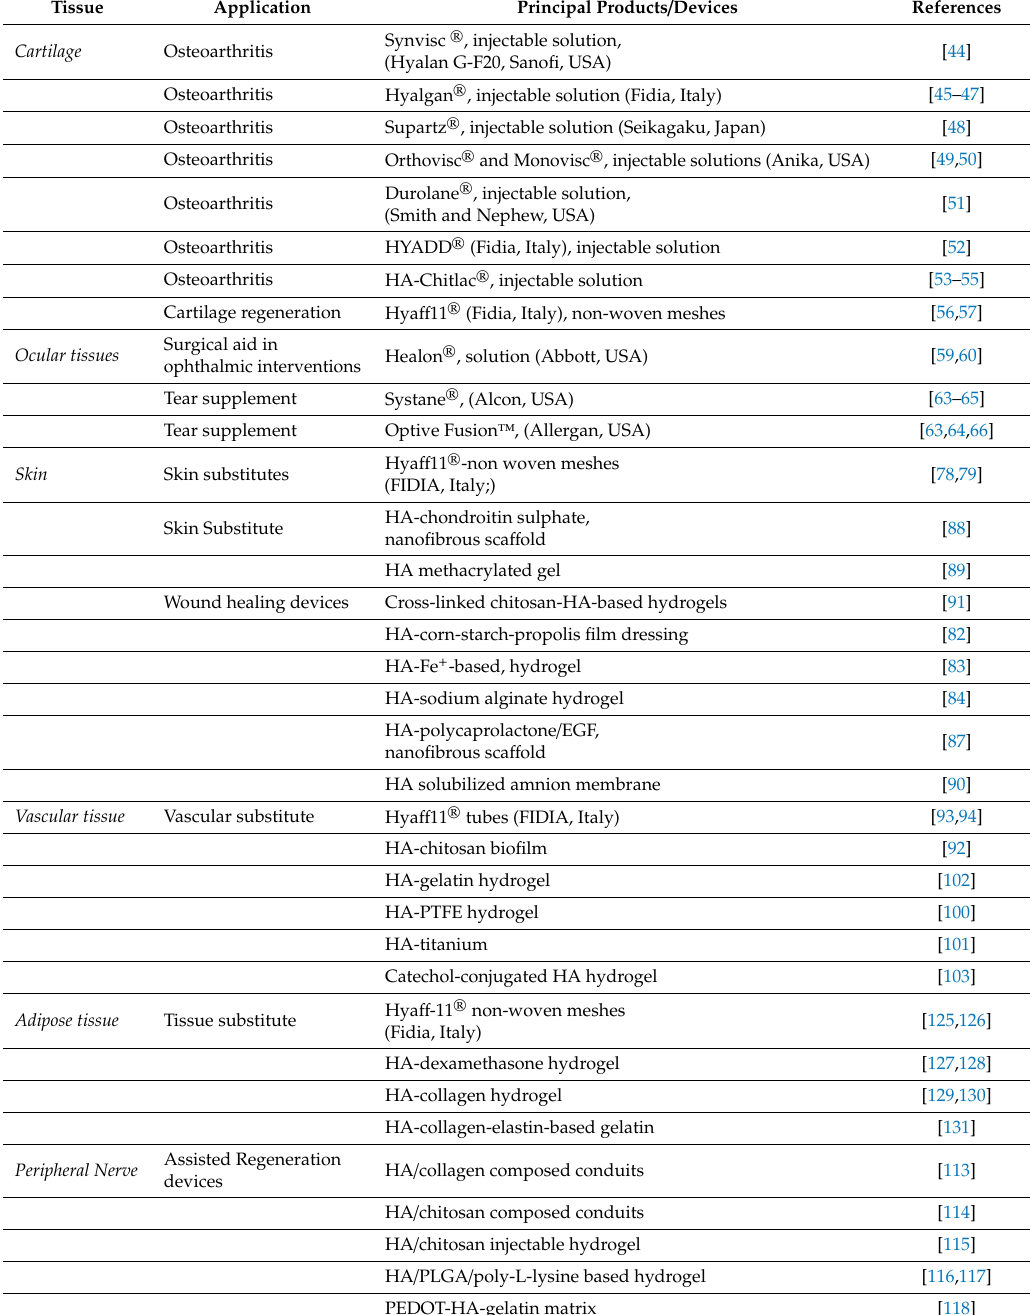
Table 1. Medical and tissue engineering hyaluronic acid (HA)